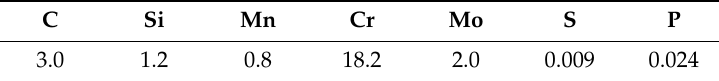
Table 1. Chemical composition of the analyzed samples (wt. %).